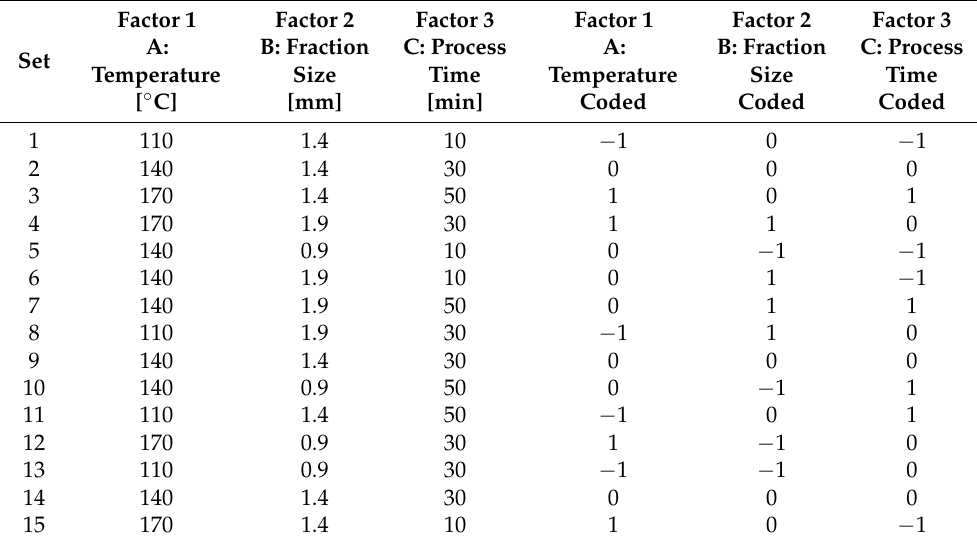
Table 1. Design of Experiment (DoE)—coded and real values of process parameters.